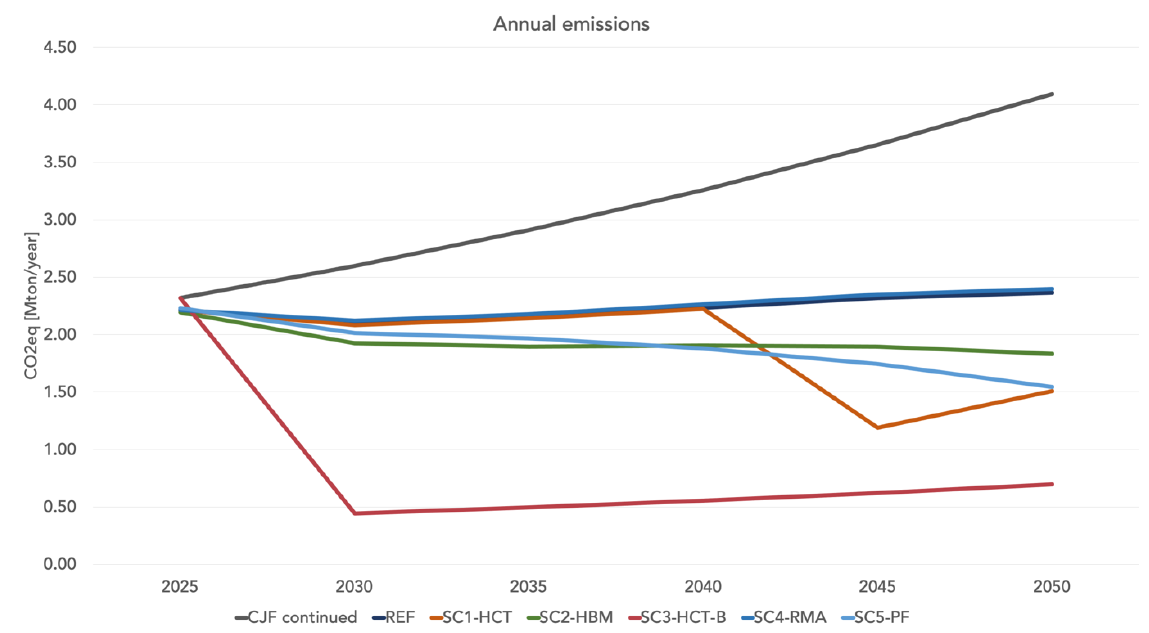
Figure 10. Annual emissions from the total system. REF (Reference scenario); SC1-HCT (Higher carbon tax); SC2-HBM (Higher blending mandate); SC4-RMA (High/Low raw material availability); SC5-PF (with penalty fee); CJF (Conventional jet fuel).